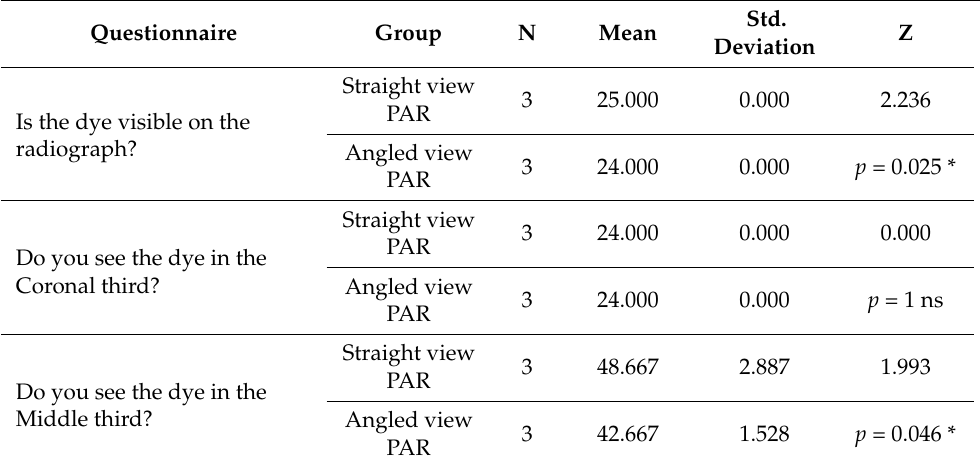
Table 4. Chi-square test based on means of Likert scale responses based on PARs for experimental group (n =